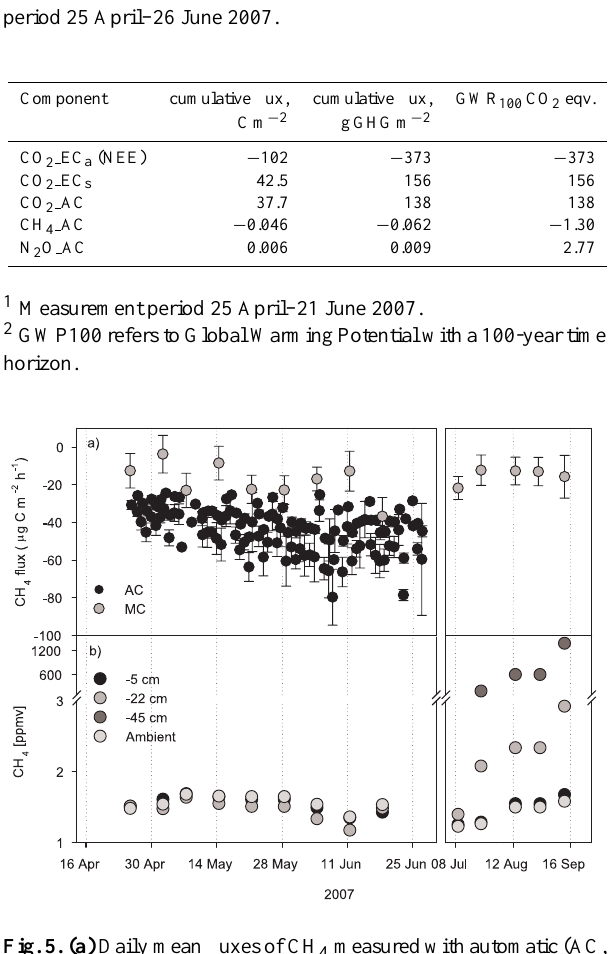
Table 2. Cumulative greenhouse gas CO 2 , CH 4 and N 2 O fluxes at the Kalevansuo drained peatland forest measured by eddy co- variance and automatic chambers during the intensive measurement period 25 April–26 June 2007.